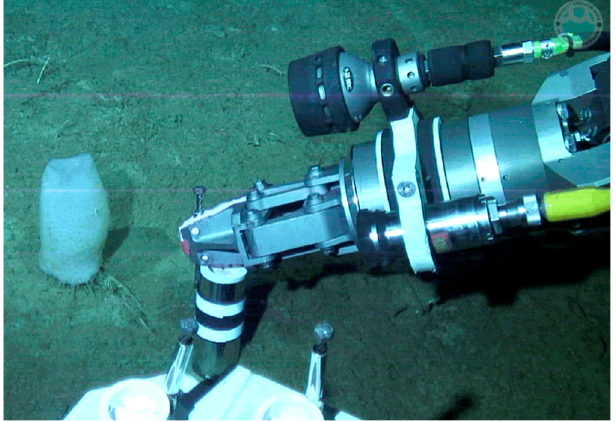
Figure 1. A manipulative operation performed using a Schilling Orion 7P